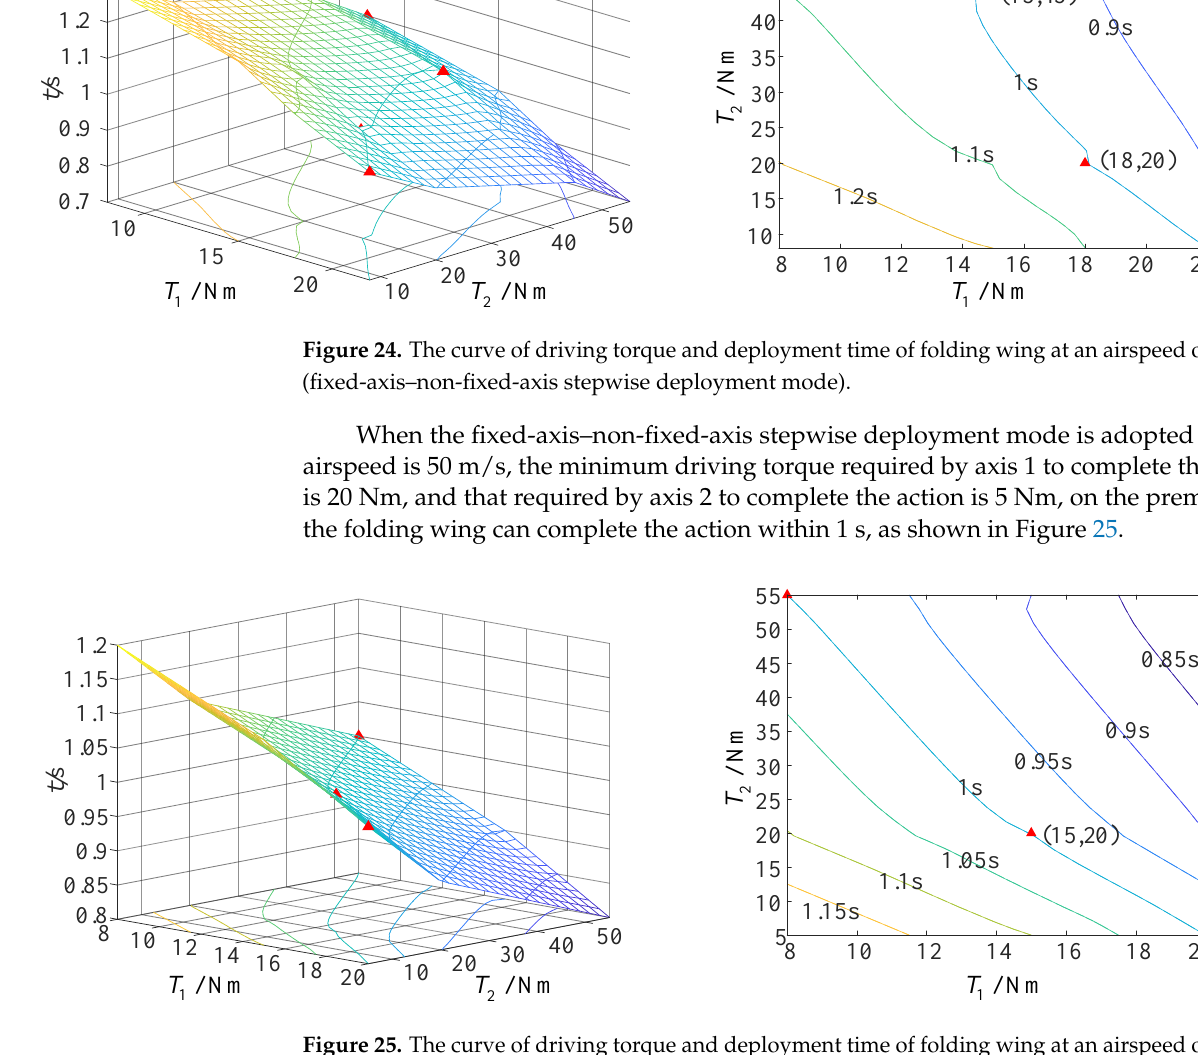
Table 3. Minimum driving torque required for folding wing deployment at different airspeed and deployment modes. Airspeed (m/s) Synchronous Deployment Mode Non-Fixed-Axis – Fixed-Axis Stepwise Deployment Mode Fixed-Axis – Non-Fixed-Axis Stepwise Deployment Mode Deployment Time (s)